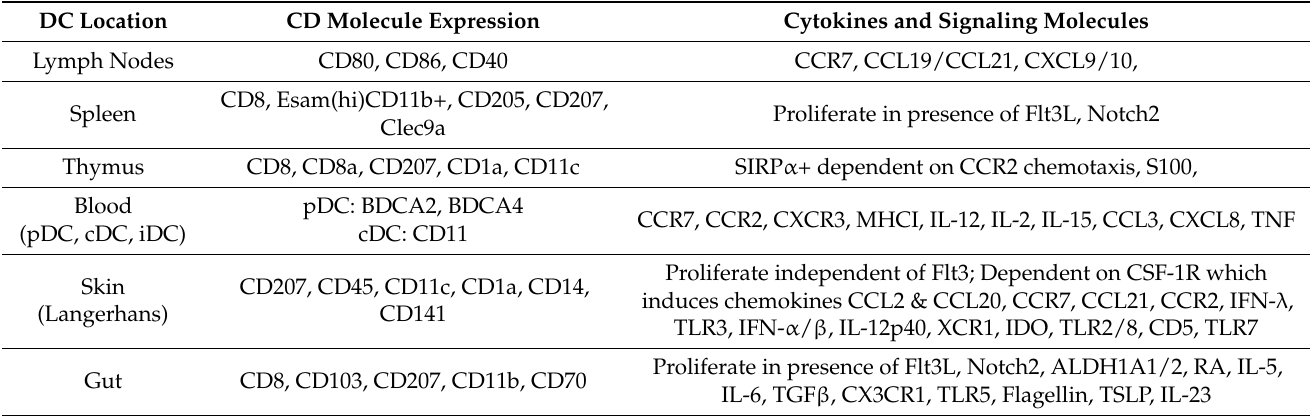
Table 1. CD markers on dendritic cell subtypes. Breakdown of DC populations by location including lymph nodes, spleen, thymus, blood, skin, and gut. Differential CD expression among this population of cells. The table also notes proliferative factors for select DC